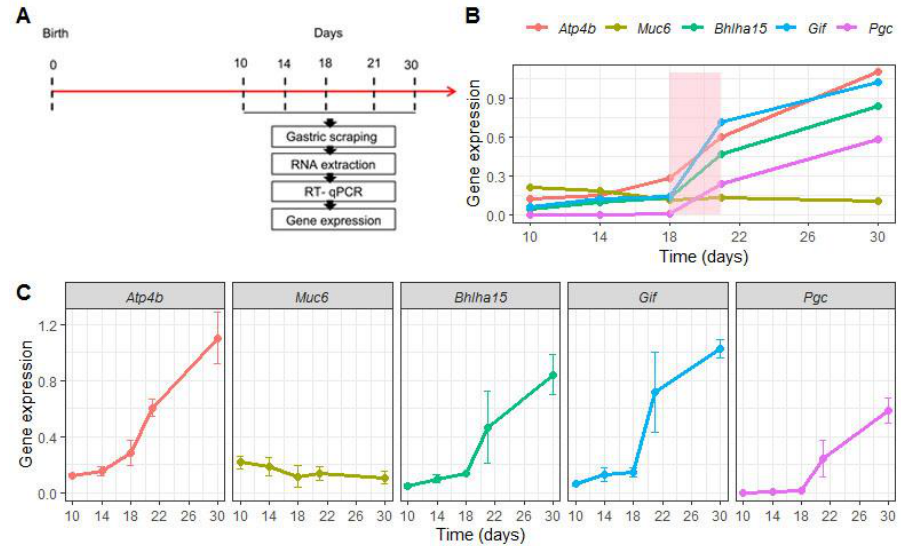
Figure 2. Expression of regulatory marker genes changes during gastric growth. ( A ) Experimental design for RNA isolation at 10, 14, 18, 21 and 30 days in suckling rats. ( B ) Comparative expression of Atp4b , Muc6 , Bhlha15 , Gif and Pgc , which are respectively important for differentiation and function of parietal cells ( Atp4b ), mucous neck cells ( Muc6 ), and zymogenic cells ( Bhlha15 , Gif and Pgc ). Levels were represented as fold induction of internal control ( Gapdh ) throughout the first postnatal month. The weaning period is colored (light pink) to identify the natural and ontogenic increase in expression of the genes studied. Each dot represents the means ± SD at each age. n = 4–5 animals. Technical replicates: n = 2. ( C ) Expression levels of each gene is separately demonstrated. One- way ANOVA was used to compare the variation throughout the first postnatal month; p < 0.05 was detected for all genes, except for Muc6 analyses that did not indicate changes.